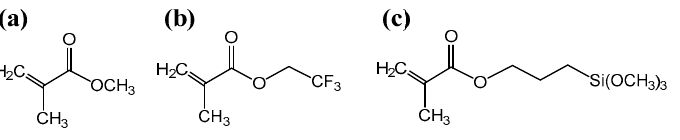
Figure 1. Monomers employed in the hybrid polymers synthesis: ( a ) methyl methacrylate (MMA); ( b ) 2,2,2-trifluoroethylmethacrylate (TFMA); ( c ) 3-methacryloxypropyl trimethoxysilane